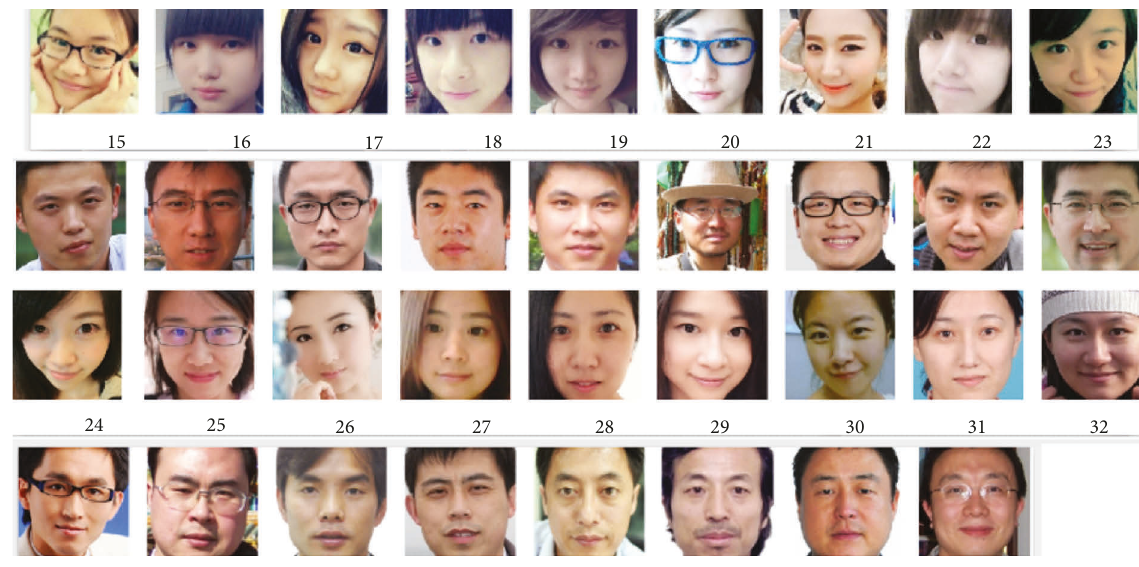
Figure 18: Asian face age data set [52].